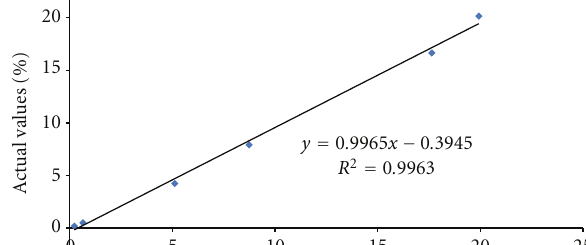
Table 3: Theoretical detection limit with sample volume recom-